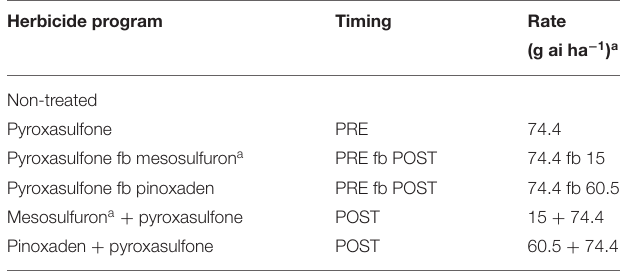
TABLE 1 | Herbicide treatment, application timing, and rates applied in no-till and conventional tillage systems for Italian ryegrass control. Herbicide